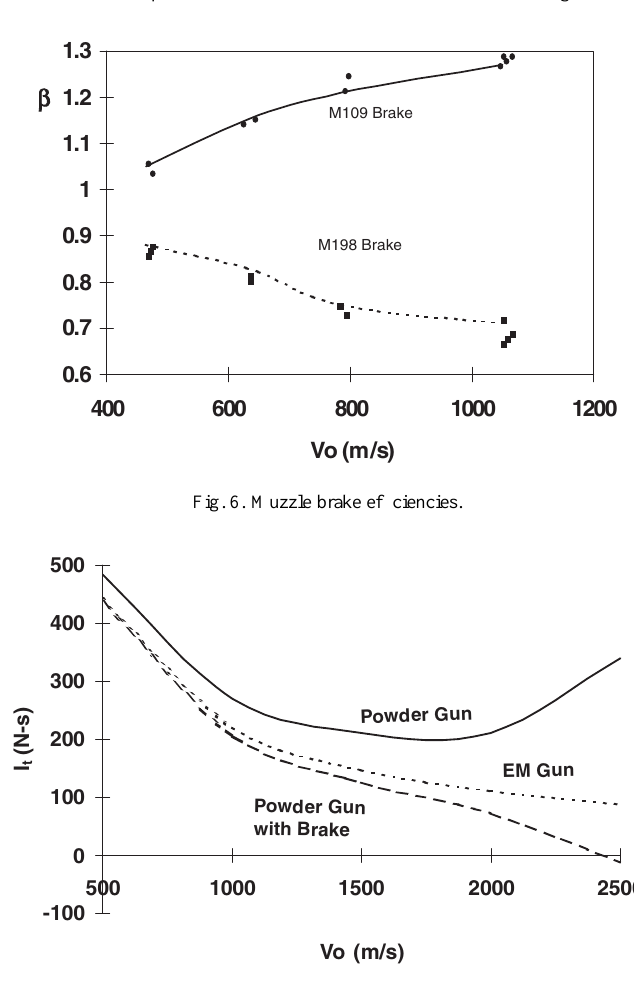
Fig. 7. Constant muzzle energy case with muzzle